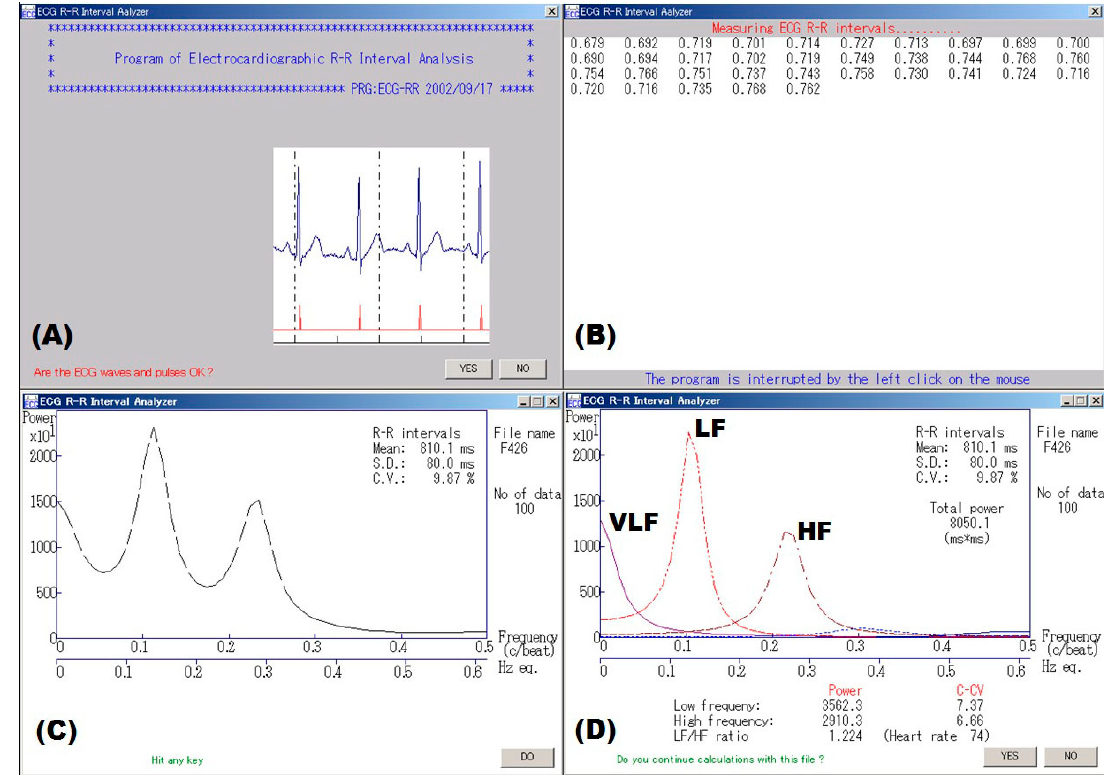
Figure 1. An example of spectral analysis of ECG R ‒ R intervals. ( A ) An examiner confirmed waveforms on the electrocardiogram. ( B ) Electrocardiographic 300 R ‒ R intervals or 5-min R ‒ R intervals were measured in real time. ( C ) Spectral analysis using autoregressive model was made for consecutive 100 R ‒ R intervals with the minimal standard deviation (SD) that were automatically extracted from the obtained data, and ( D ) component analysis was made for the data. Finally, a coefficient of variation (C.V. or CV RR ) was calculated from the mean and SD of the same data. VLF, LF, and HF represent very low frequency, low frequency and high frequency bands, respectively.